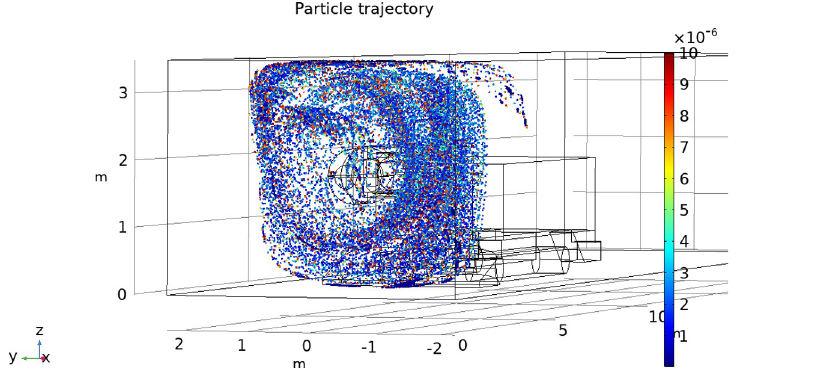
Fig 10. Particle